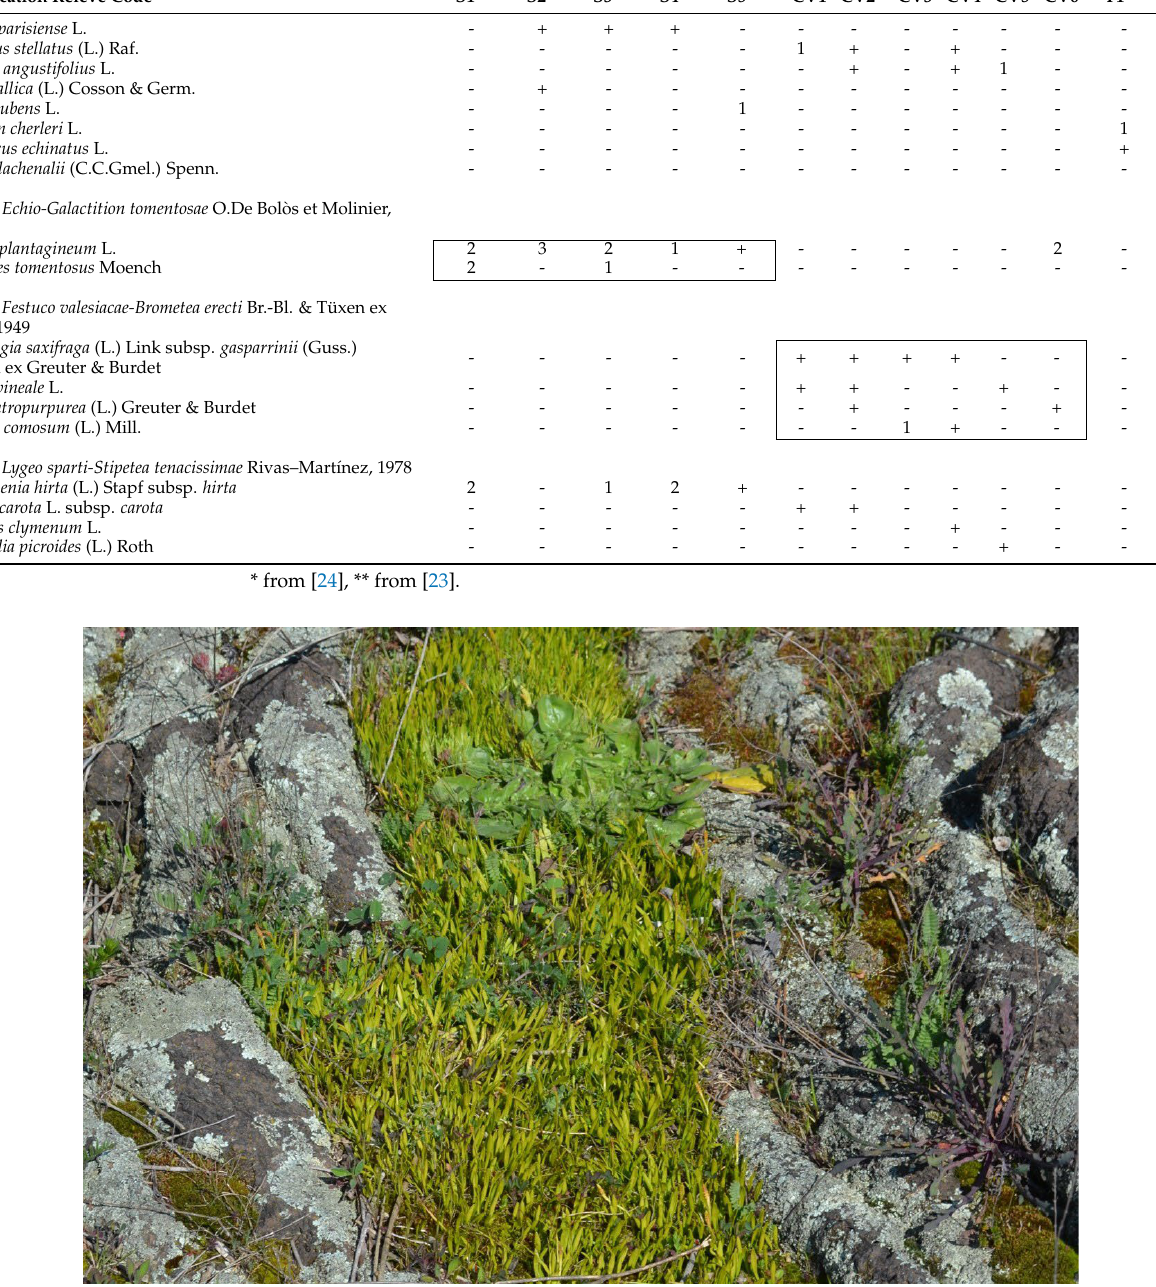
Figure 6. Rumici bucephalophori-Ophioglossetum lusitanici subass. trifolietosum scabri subass. nova hoc loco. Date: 19 March 2016, Mt. Vesuvius, Ercolano, between Casa Cantoniera and Osservatorio Vesuviano (Naples). Photo by Adriano Stinca.